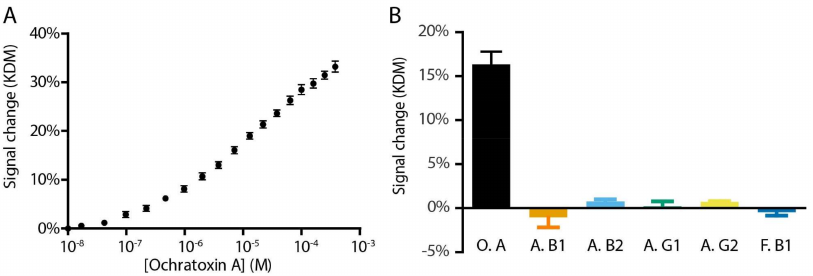
Figure 4. The E-AB ochratoxin sensor is selective enough to work when challenged directly in a realistically complex sample matrix, and highly specific for its target. ( A ) Shown here, for example, are data collected in flowing, undiluted coffee. Error bars shown are standard error of the mean for six replicate electrodes. ( B ) The E-sensor is also highly specific for its target, ochratoxin A (O. A); it does not respond to the mycotoxins, Aflatoxin B1 (A. B1), Aflatoxin B2 (A. B2), Aflatoxin G1 (A. G1), Aflatoxin G2 (A. G2), or Fumonisin B1 (F. B1). Each bar represents the KDM signal gain of sensors in buffer challenged with 10 µ M of mycotoxin, error bars reflect the standard error of the mean for three replicate